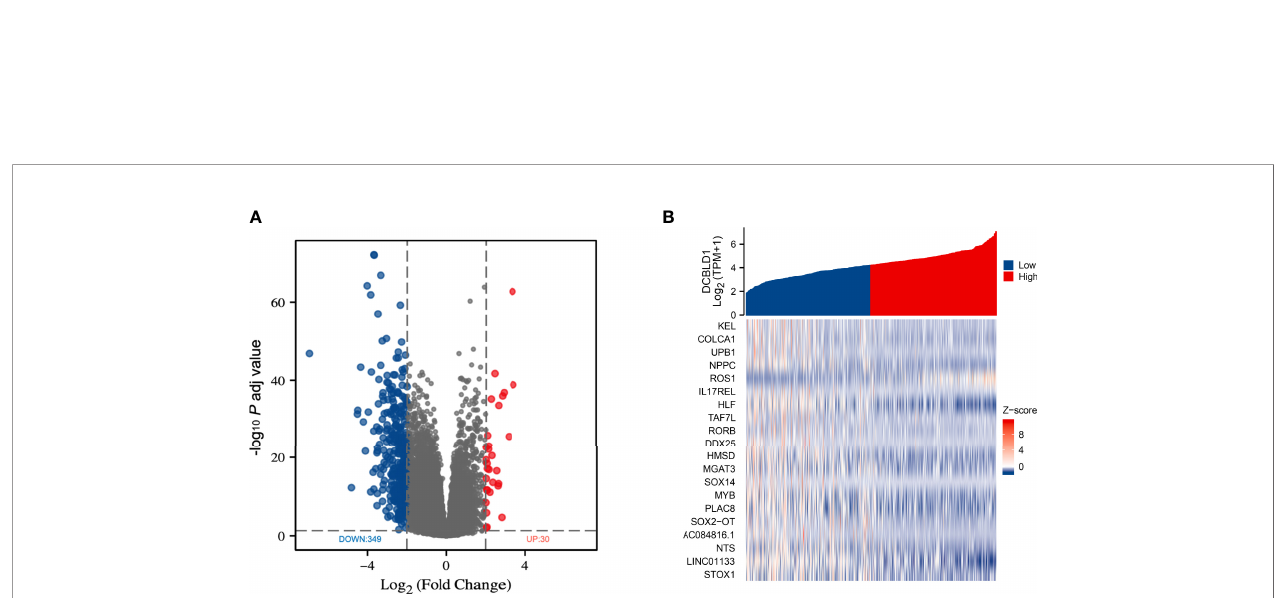
FIGURE 2 | Differentially expressed genes in HNSCC with high and low DCBLD1 expressions. (A) Volcano plot of DEGs; the downregulated genes were in blue ( n = 349), and the upregulated genes were in red ( n = 30). (B) Heatmap of the top 20 DEGs between high and low DCBLD1